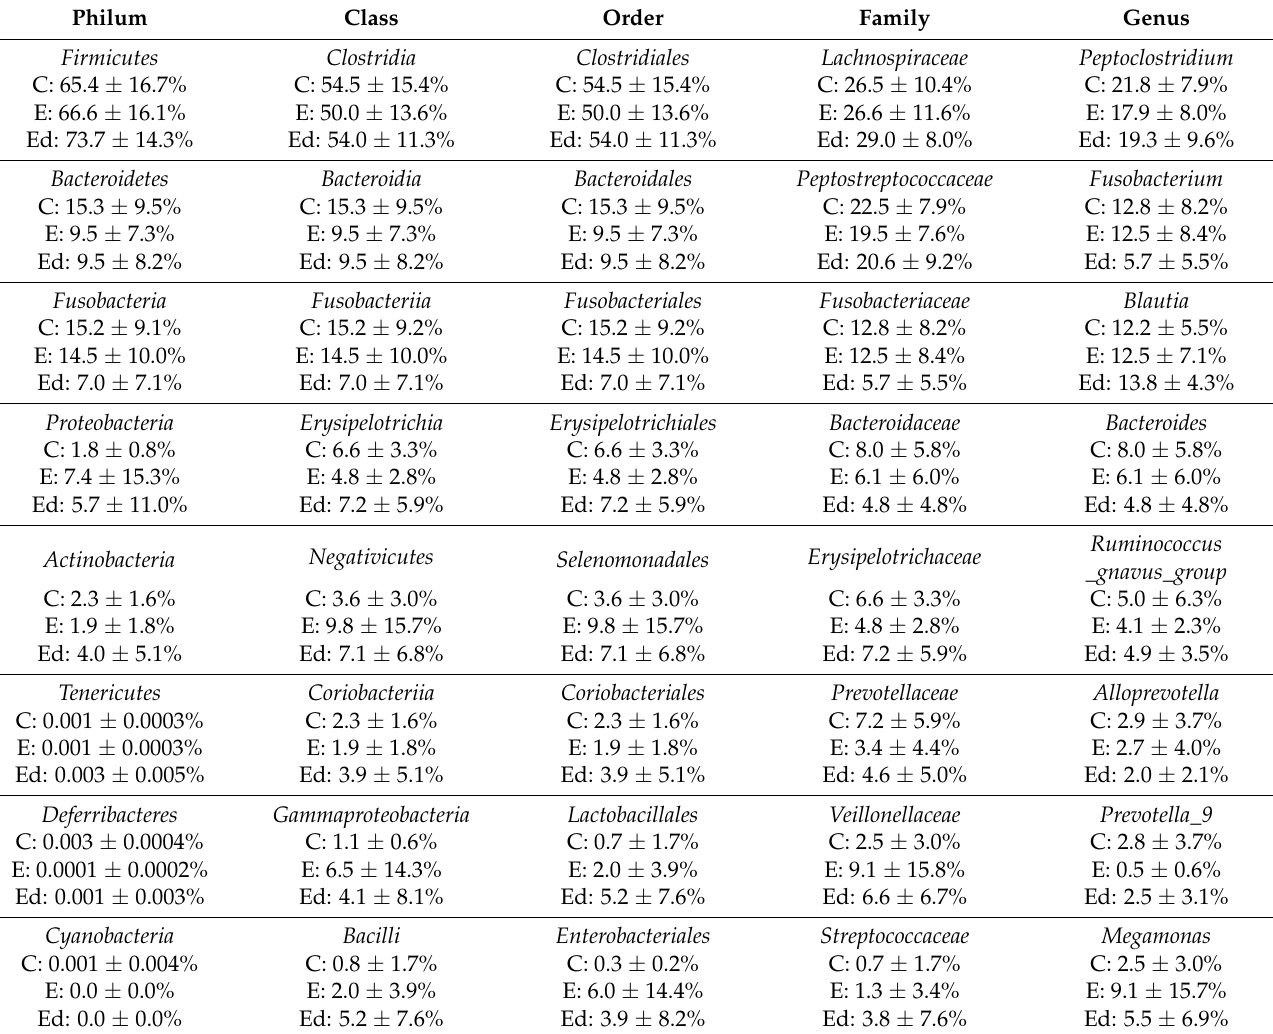
Table 1. Relative abundance (percentage in decreasing order) of top ten bacteria groups belonging to different taxa from phyla to genus in healthy controls (C, n = 12), drug-naïve epileptic dogs (E, n = 10) and treated epileptic dogs with an AED (Ed, n =